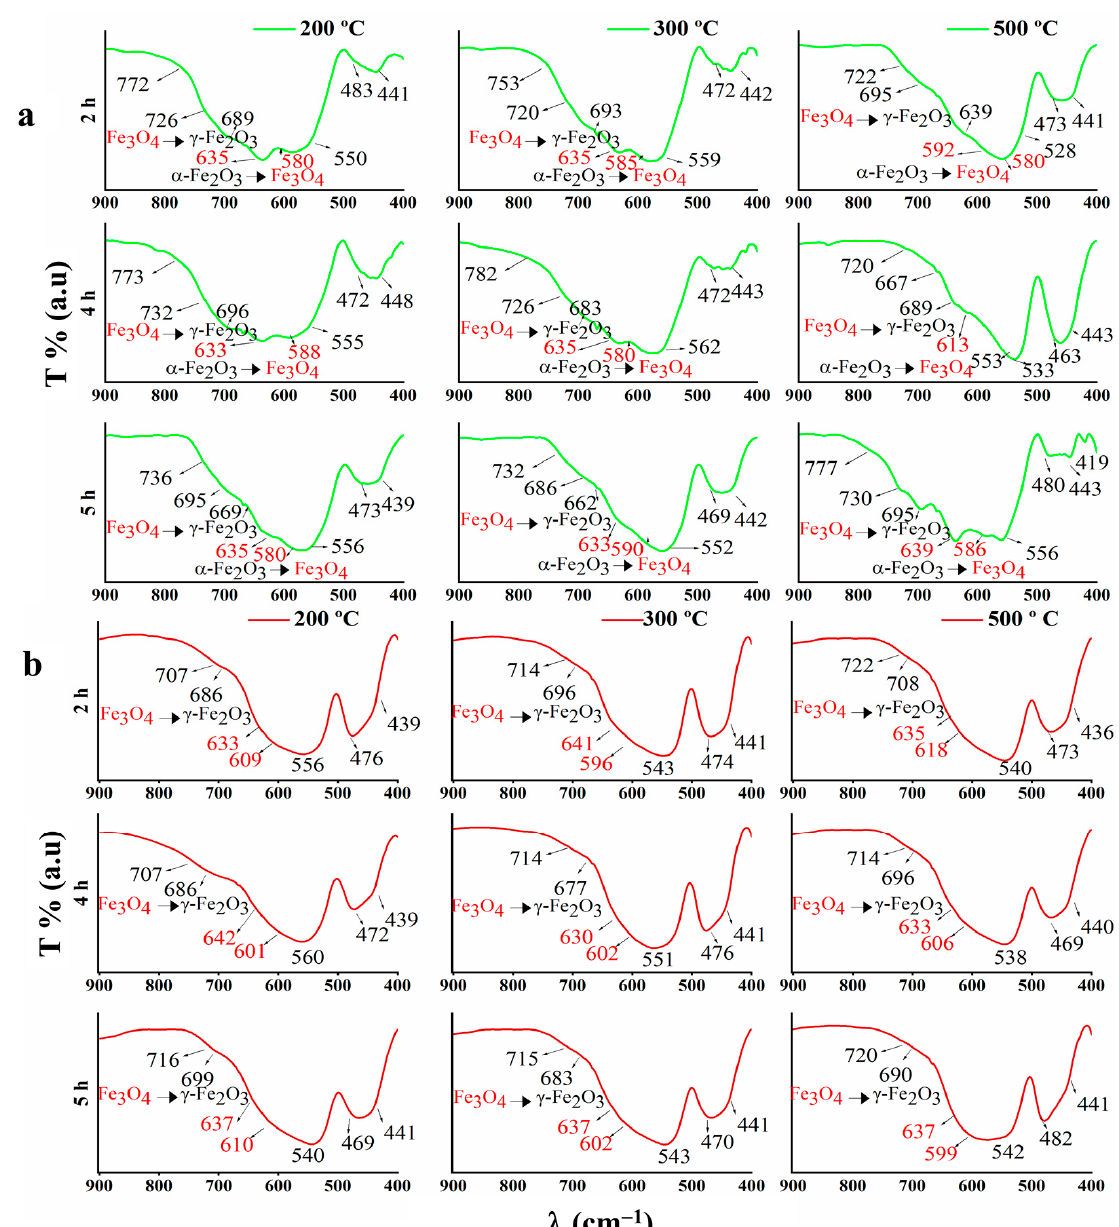
Figure 3. Fingerprint region of FTIR spectra in the (900–400 cm − 1 ) of the nanoparticles calcinated at different temperatures (200, 300, and 500 °C) and times (2, 3, and 5 h): ( a ) GS-NPs profile using aqueous extracts of PDL and ( b ) CS-NPs profile using NaOH.